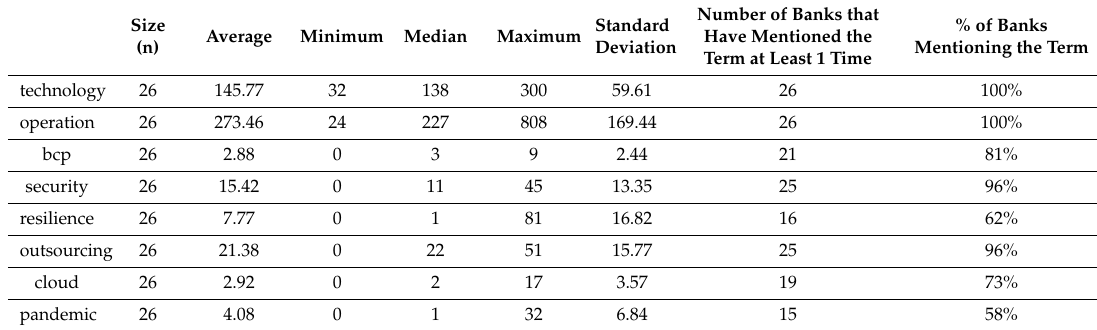
Table 4. Descriptive statistics for the terms studied from the annual reports of the